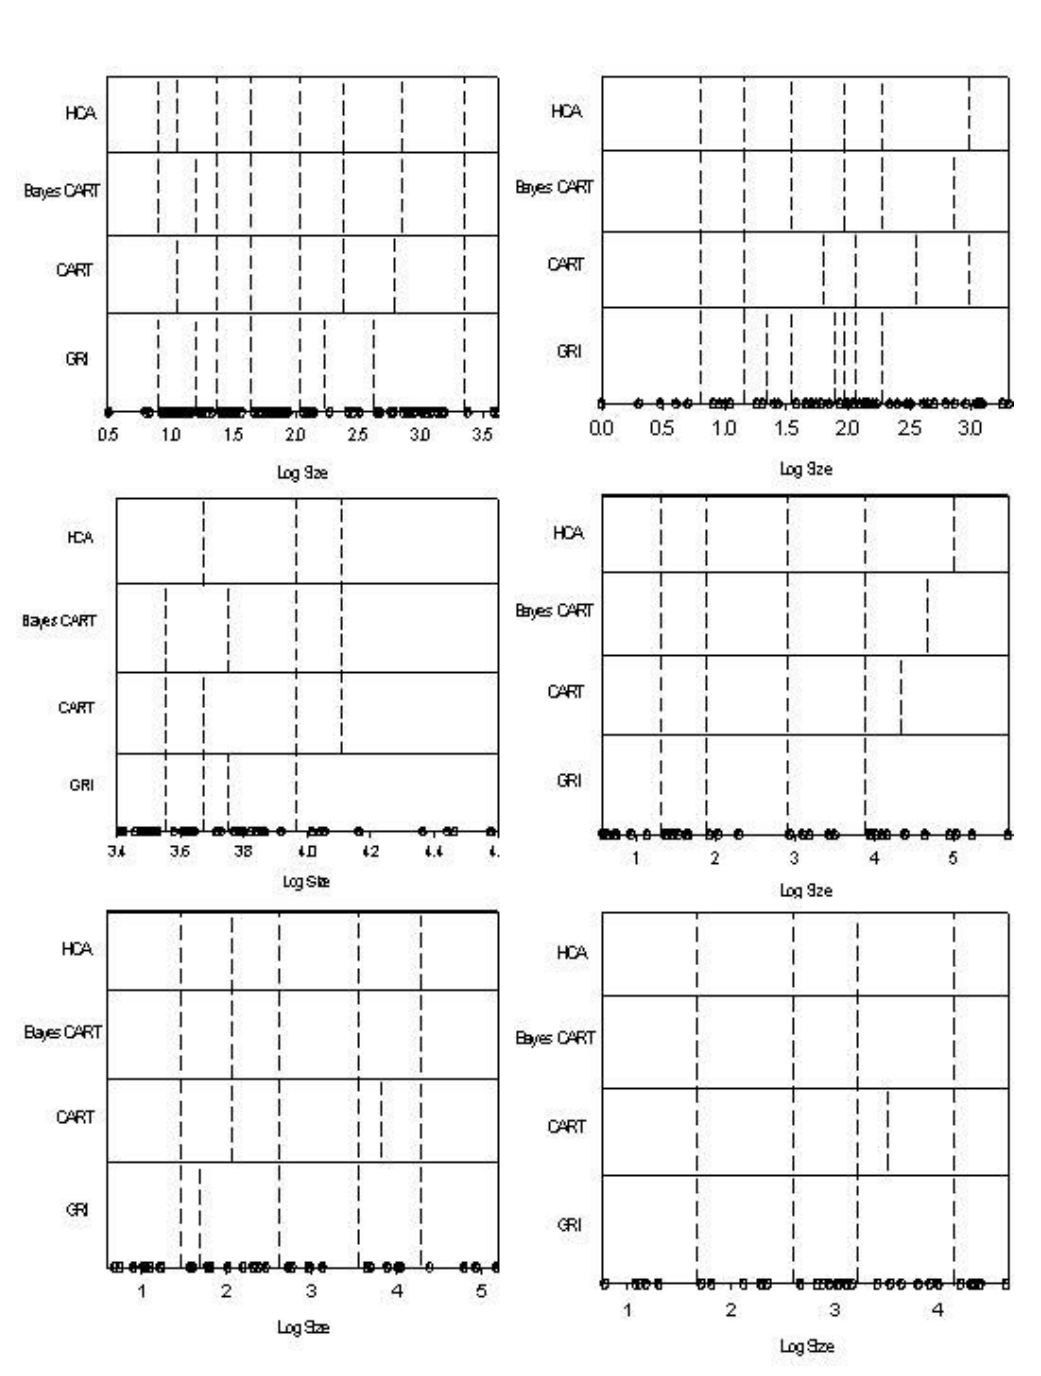
Fig. 4. Discontinuities detected by HCA, BCART, CART, and GRI approaches for boreal forest birds (top left), firm size SIC 226 (top right), SW cities 1890 (middle left), boreal forest mammals (middle right), Everglades mammals (bottom left), and Mediterranean mammals (bottom right). Dots at bottom represent data used in each analysis, dashed lines depict gaps